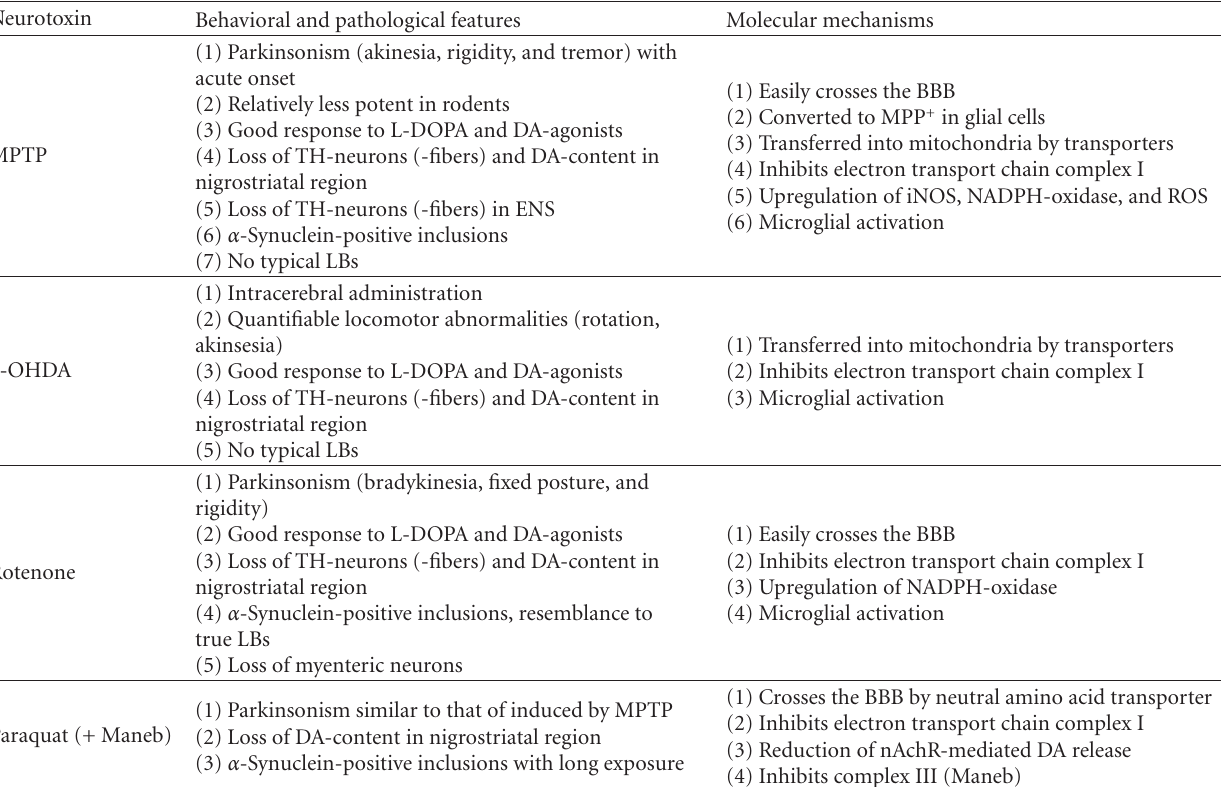
Table 1: Representative neurotoxin-induced mammalian models of Parkinson’s